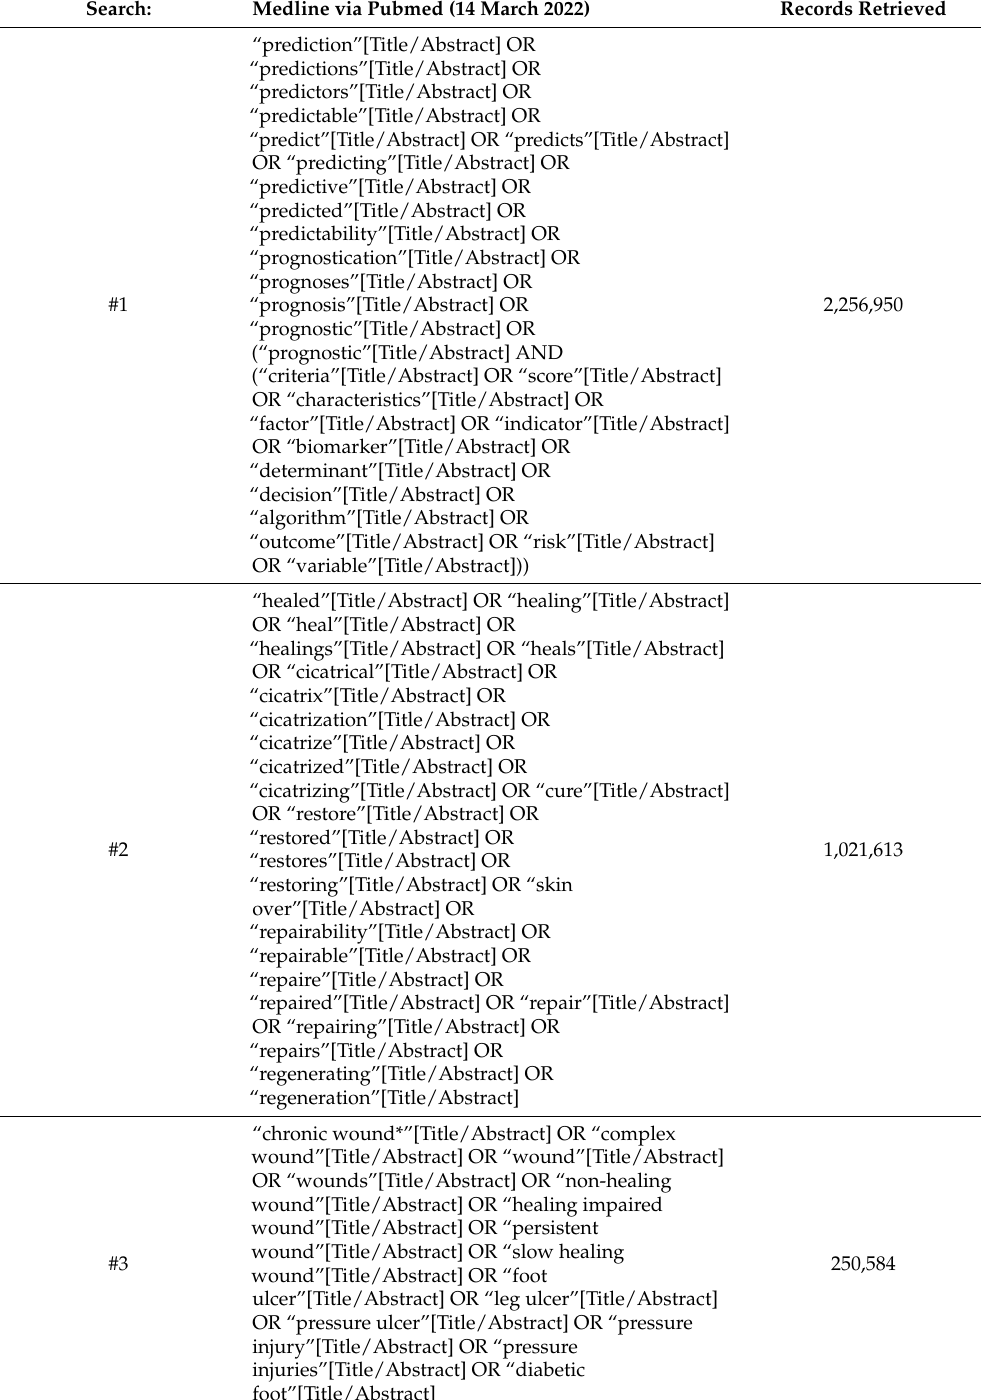
Table A1. Search strategy used in one of the databases—MEDLINE (via PubMed)—in March